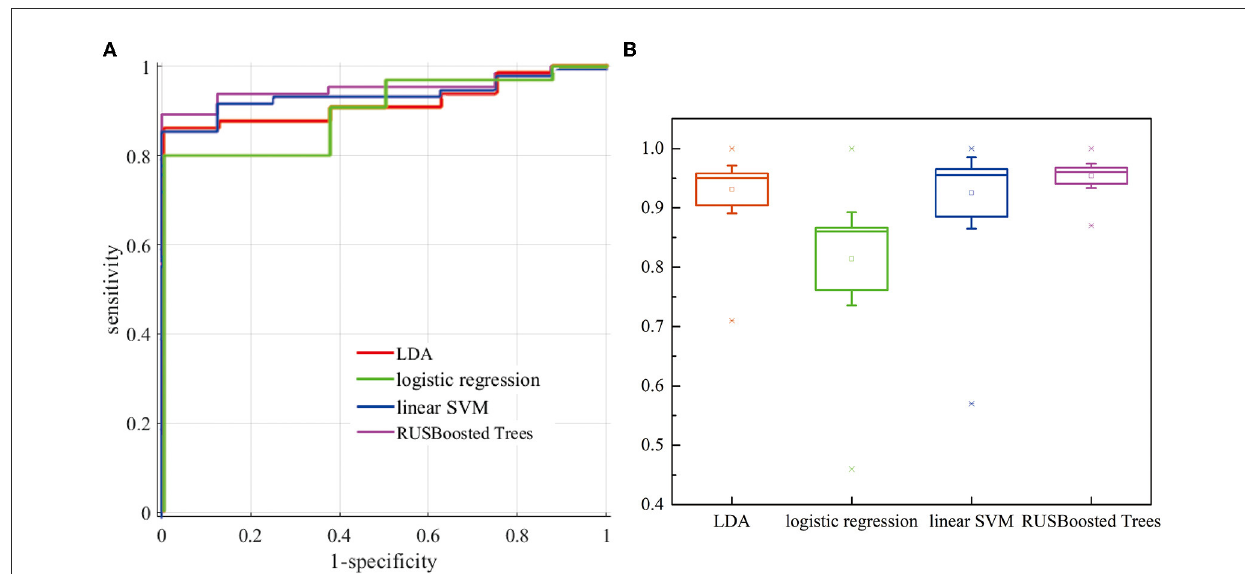
FIGURE11 (A) Evaluation of the ROC curves (the plot of sensitivity vs. (1-specificity) for distinguishing k-complexes) for subjects 1. (B) Comparison of AUC for different